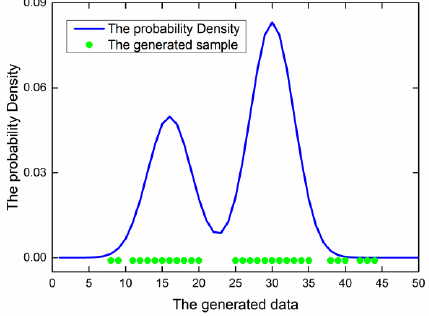
Figure 4. The one-dimensional Gaussian mixture distribution. Figure 4. The one ‐ dimensional Gaussian mixture distribution. Figure 4. The one ‐ dimensional Gaussian mixture Figure 4. The one ‐ dimensional Gaussian mixture distribution.